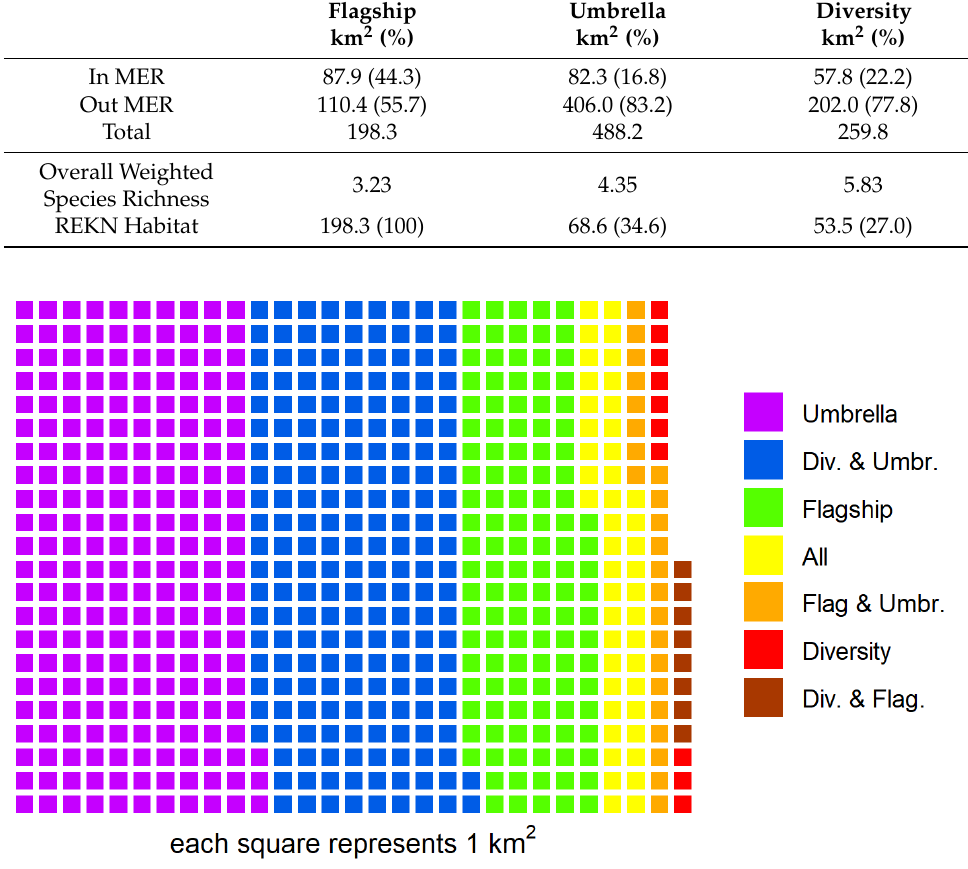
Figure 4. Relative composition of the sum total intertidal habitat area designated by the different management approaches.